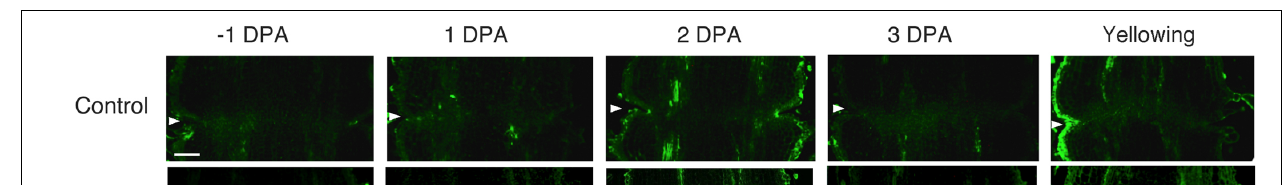
pedicels, including the AZ, were stained with the antibodies LM6 (anti-arabinan) and LM15 (anti-xyloglucan). Micrographs show the negative control without the first antibody step. Arrowheads indicate the AZs. Bar = 0.2 mm.